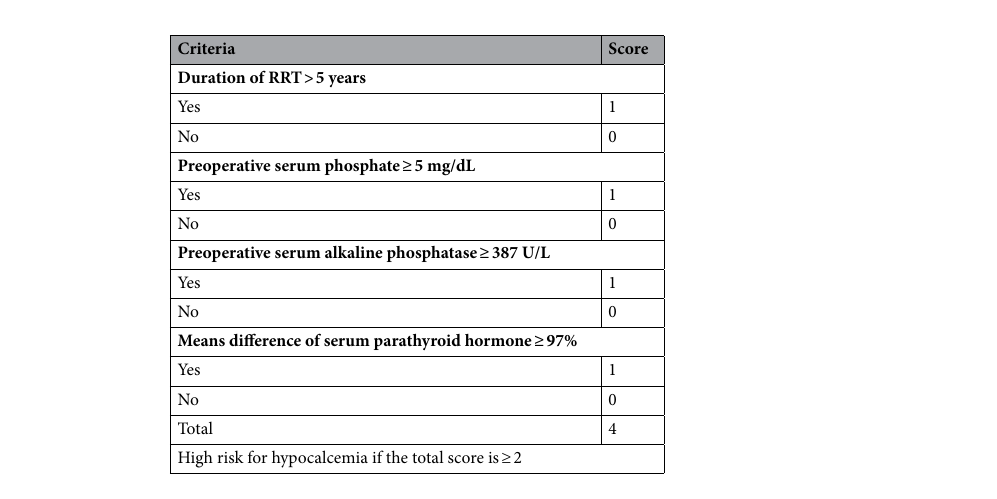
Table 4. Risk score for the diagnosis of post-parathyroidectomy hypocalcemia.